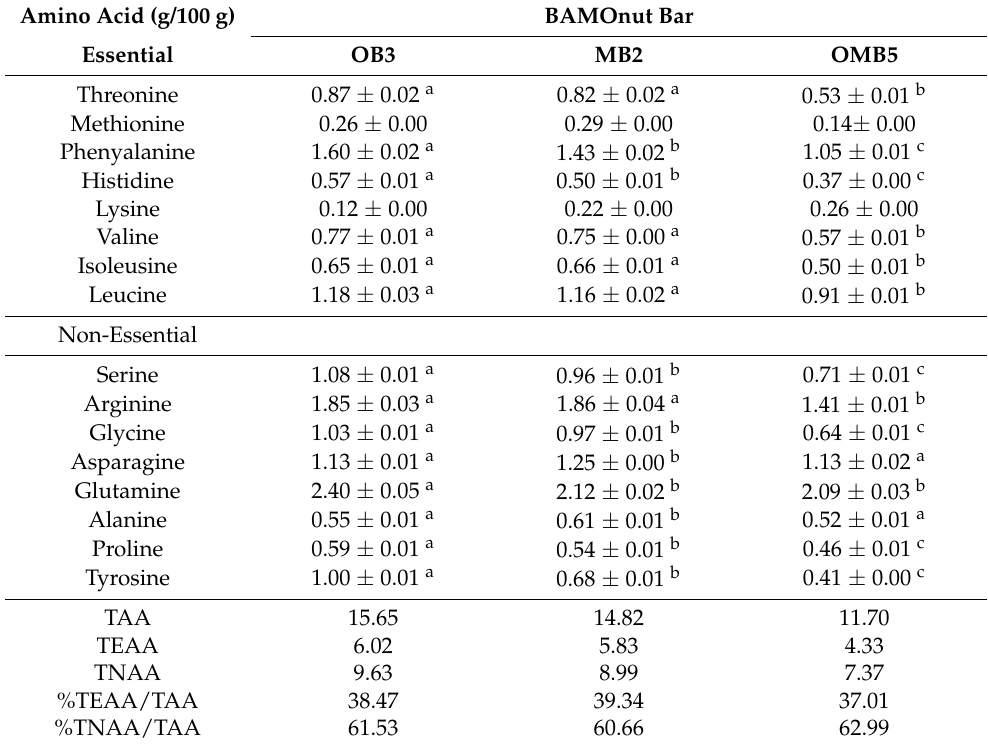
Table 7. Amino acid composition of